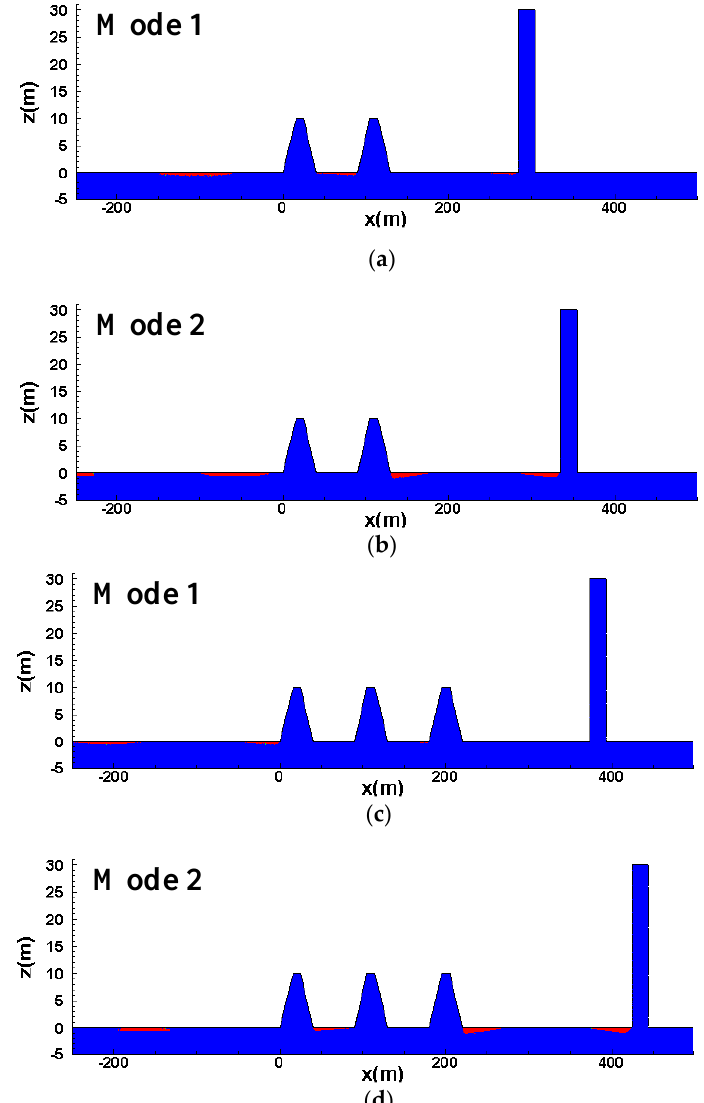
Figure 25. Distribution of the wave−induced liquefaction zone around the breakwaters with a period of kd = 0.6 at t / T = 0.75. ( a ) m = 2 and S / L = 0.75; ( b ) m = 2 and S / L = 1.0; ( c ) m = 3 and S / L = 0.75; ( d ) m = 3 and S / L = 1.0.